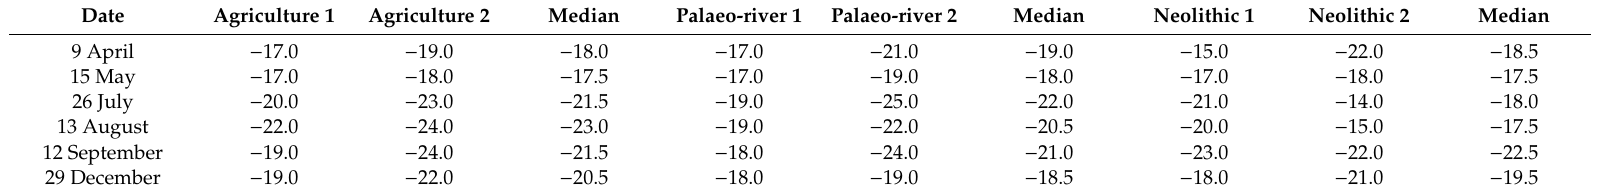
Table A4. Backscatter values for the Sentinel 1 2019 Sigma0-VH descending pass direction.